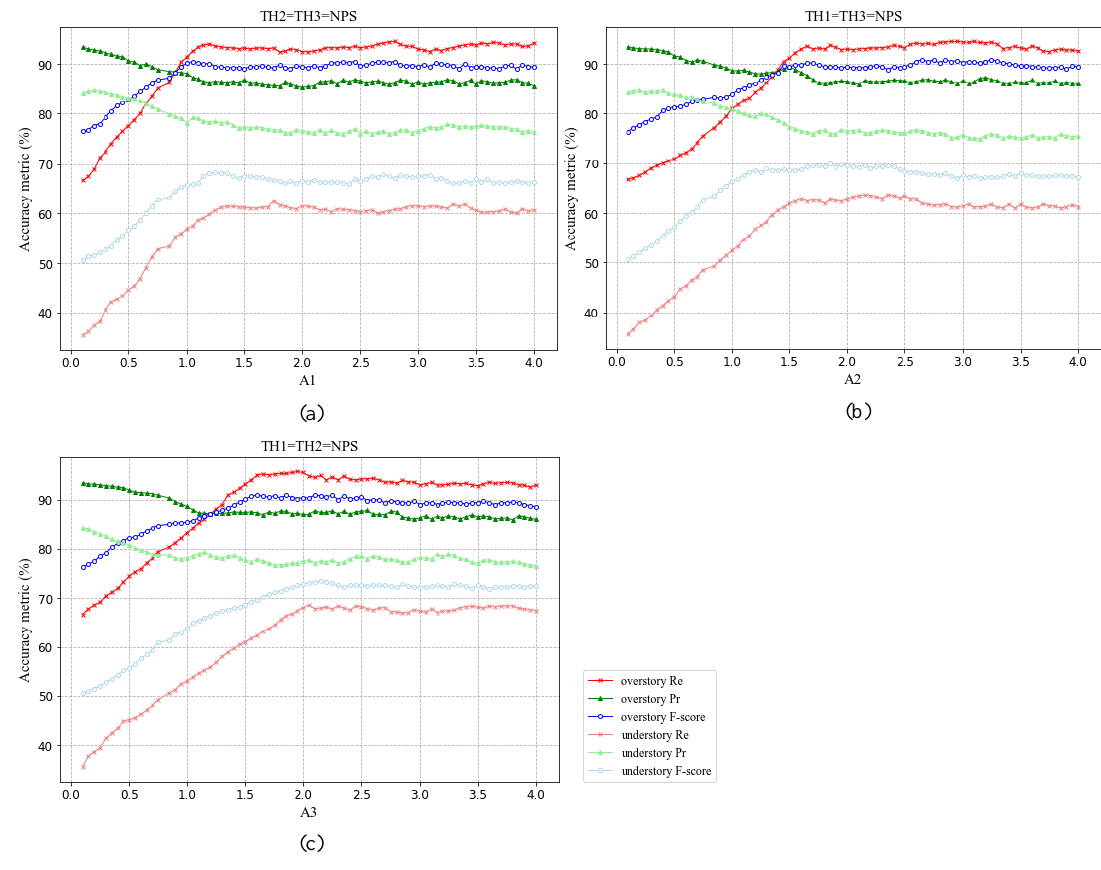
Figure 11. Effect of Different Thresholds on the Segmentation Accuracy of Each Layer. ( a ), ( b ) and ( c ) represent the effects of TH1, TH2, and TH3, respectively.